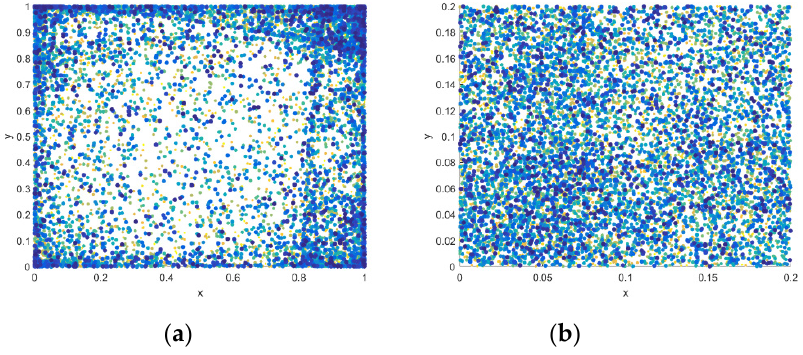
Figure 1. Phase diagrams of 2D-LASM and 2D-ILASM: ( a ) 2D-LASM; ( b ) 2D-ILASM.